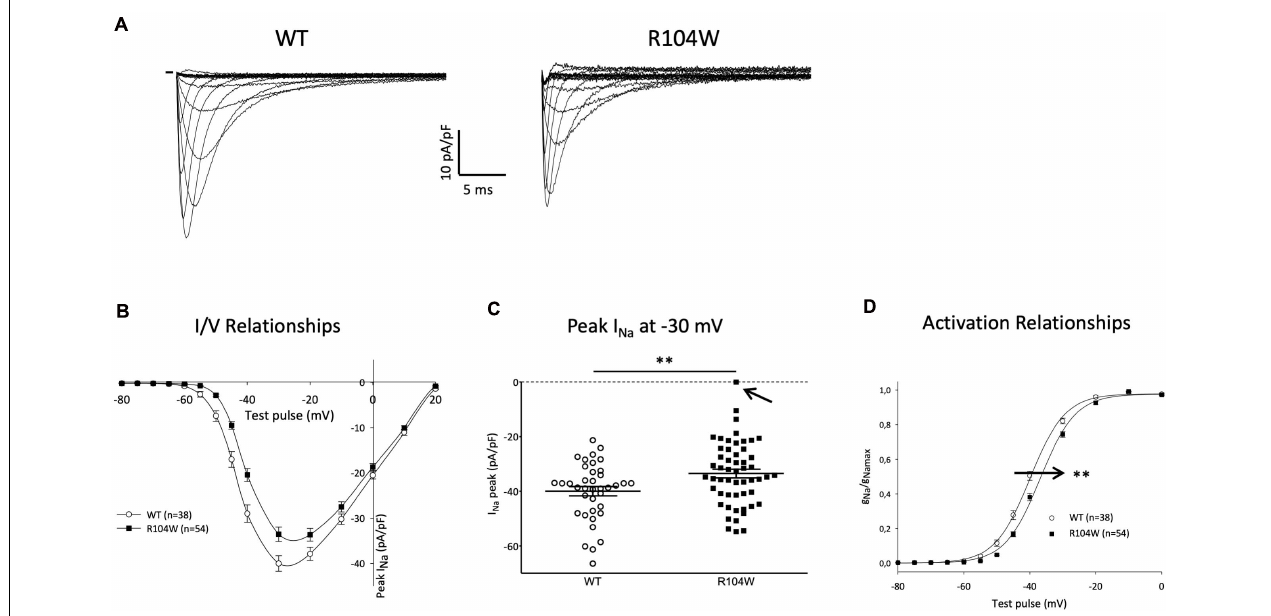
FIGURE 4 | Overexpression of the hNa v 1.5-R104W mutant decreased endogenous I Na . (A) Typical Na + currents recorded in control (WT, 10 mM Na + outside) and hNa